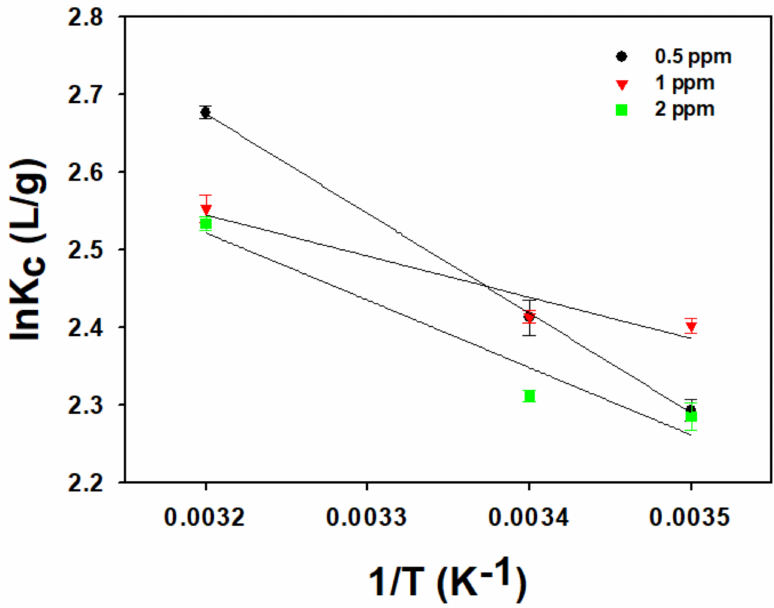
Figure 6. The plots of ln( Kc ) vs. 1/T for ciprofloxacin adsorption on to GO/Ca-Alg 2 –PAM at 283, 298, and 313